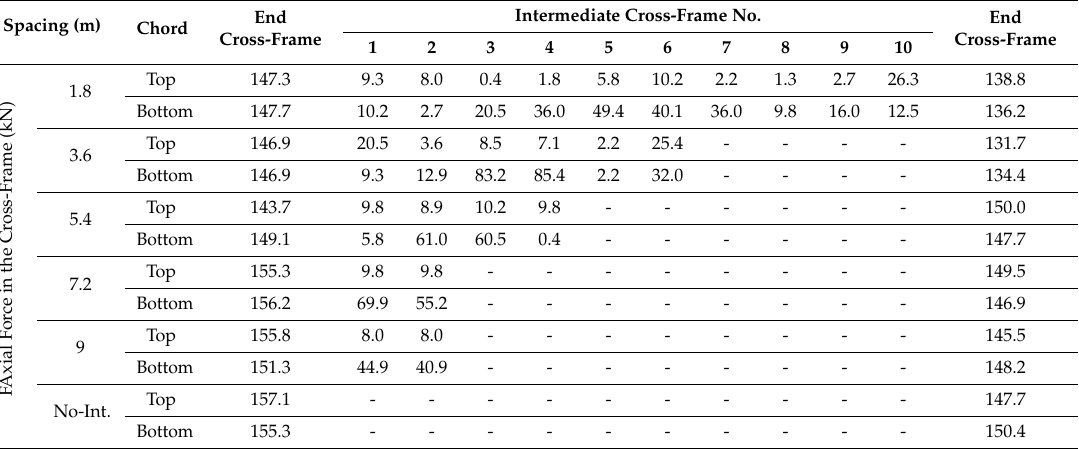
Figure 6. Load-deflection curve of the fractured girder at mid-span. ( a ) Different cross-frame layouts, ( b ) Different cross-frame spacing. Table 2. Axial force in the cross-frames between the fractured and interior girders under dead load and one- time HL93 loading.